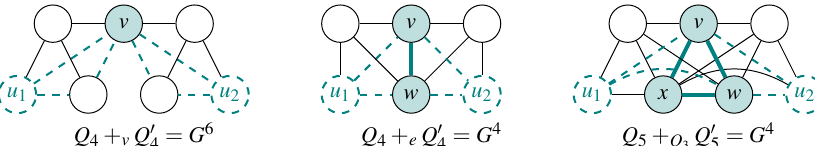
Figure 4. Glued cliques Q k and Q (cid:48) k —via the vertex, via the edge, and via the clique Q 3 . From the first picture, it is obvious that the glued graph via the vertex has d ct ( u 1 , u 2 ) obvious that the glued graph via the edge or triangle has d ct ( u 1 , u 2 ) the edge or via the subclique create a graph from the set G 4